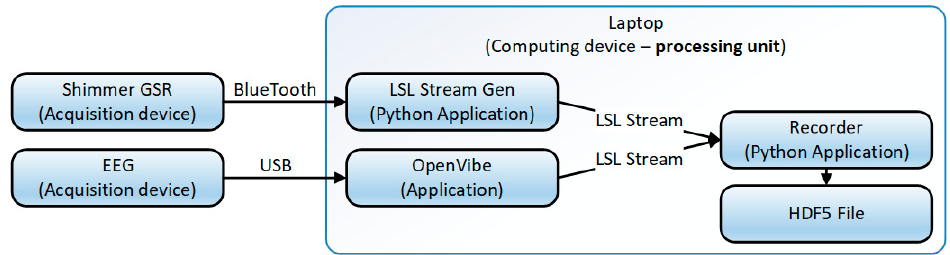
Figure 10. The data acquisition process. LSL, lab streaming layer.